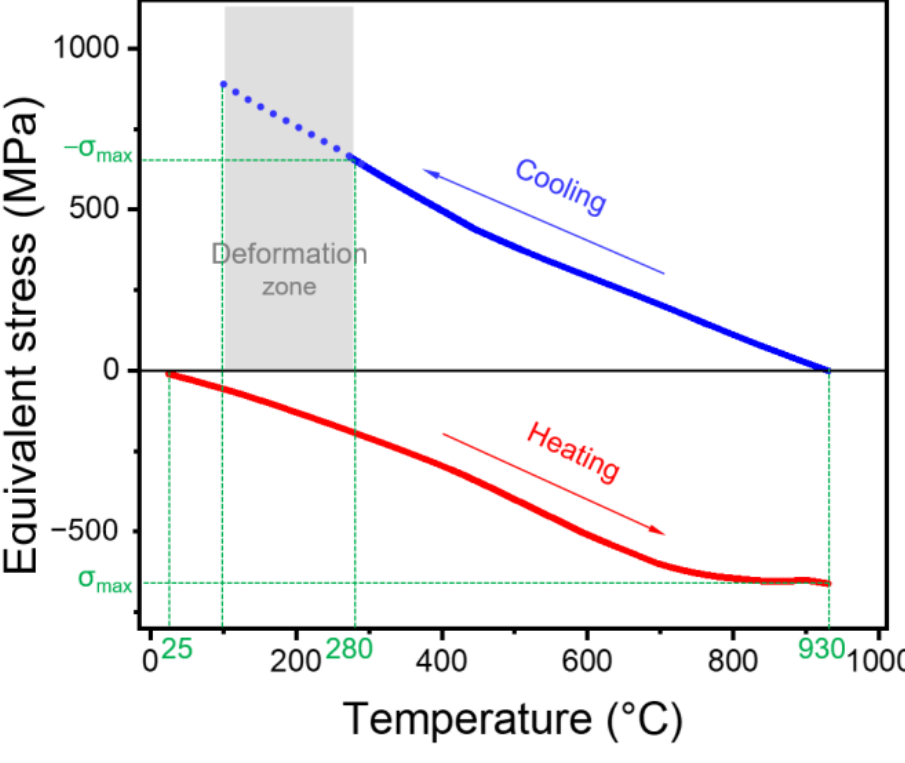
Figure 6. Simulation-based equivalent stress applied in the Cr film as a function of temperature during heating and cooling processes.